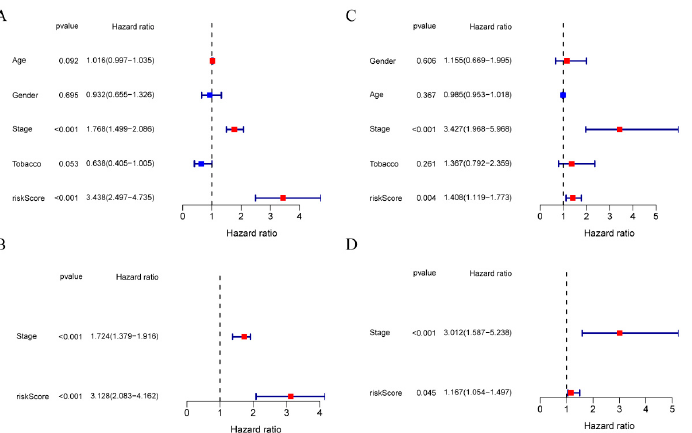
Figure 3. Comparison of clinicopathological features and risk score accuracy in prognosis prediction. TCGA ( A , B ) and GEO ( C , D ) cohorts. ( A , C ) OS-associated factors selected through univariate Cox regression. ( B , D ) OS-associated elements selected through multivariate Cox regression.